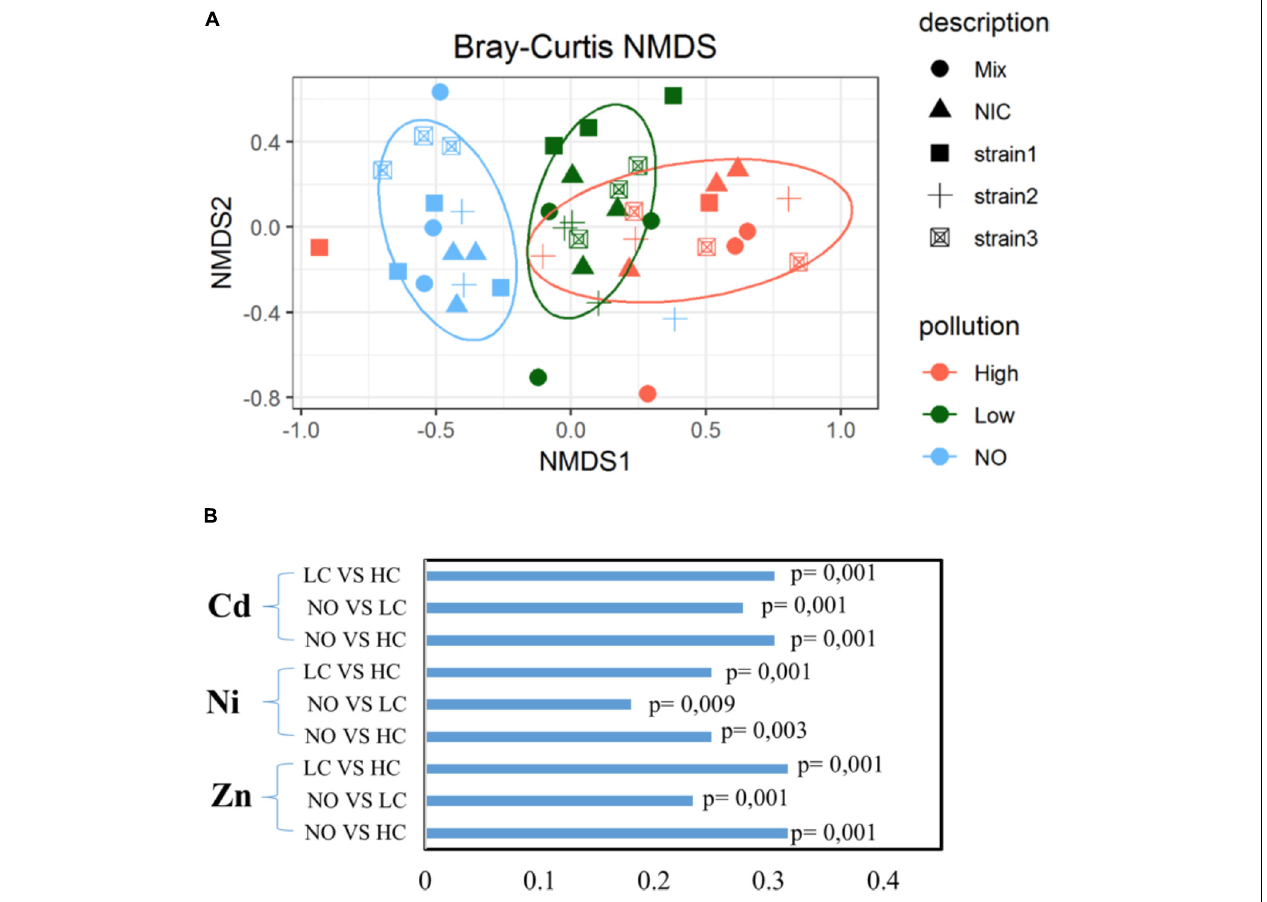
FIGURE 2 | Similarity of the root endophytic communities across a mixed pollution gradient (A) . Distance between the samples is based on similarity of the community composition visualized in non-metric multidimensional scaling (NMDS). (B) Phylogenetic correlation of root bacterial communities across metal gradient in roots using the Mantel test (999